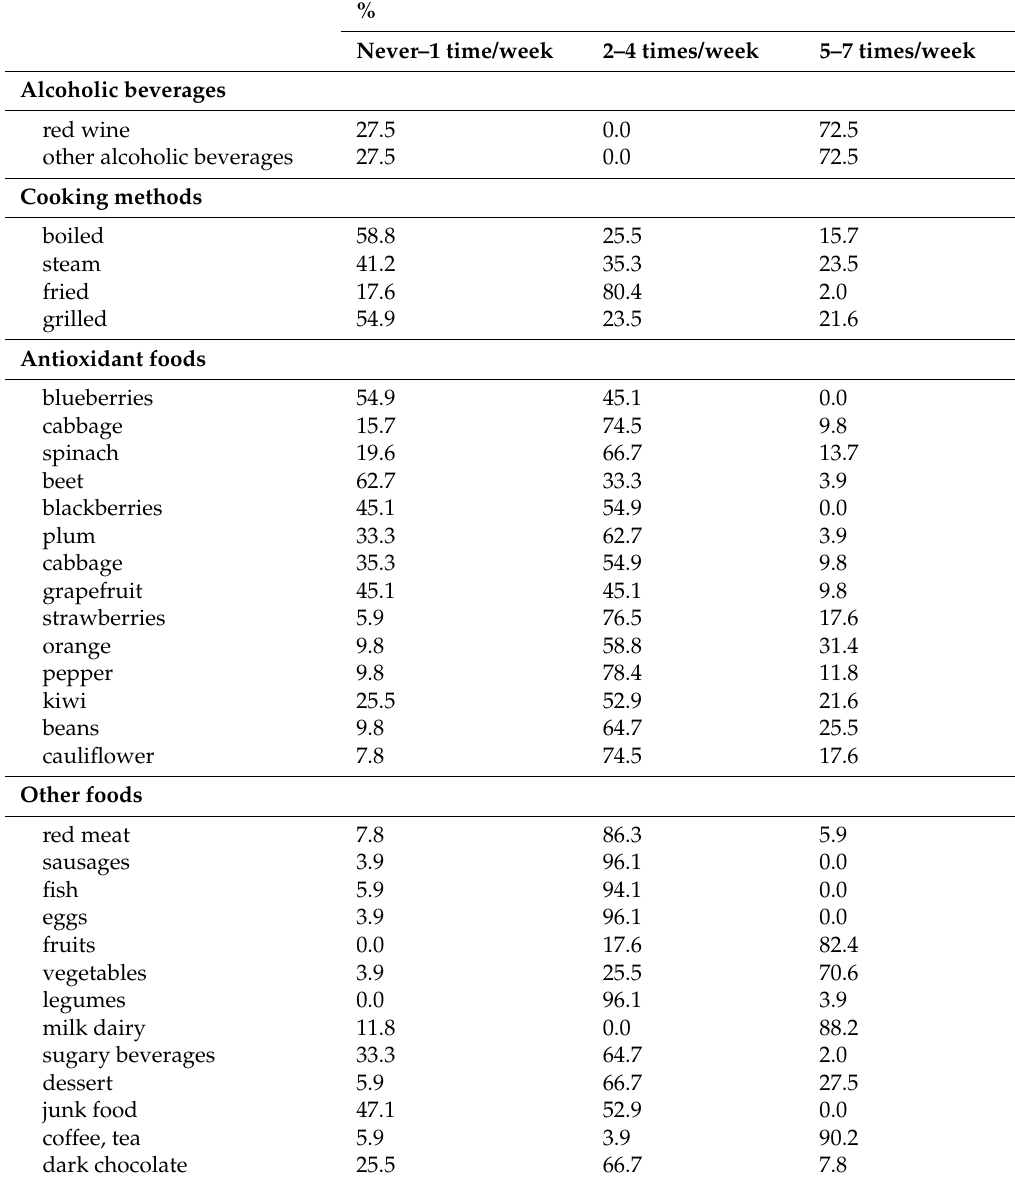
Table 4. Frequency percentage of specific food intake of all 51